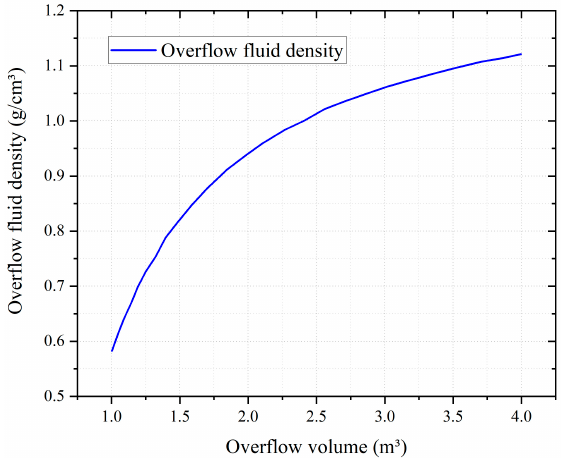
Figure 12. Influence of kick fluid volume on overflow fluid density.